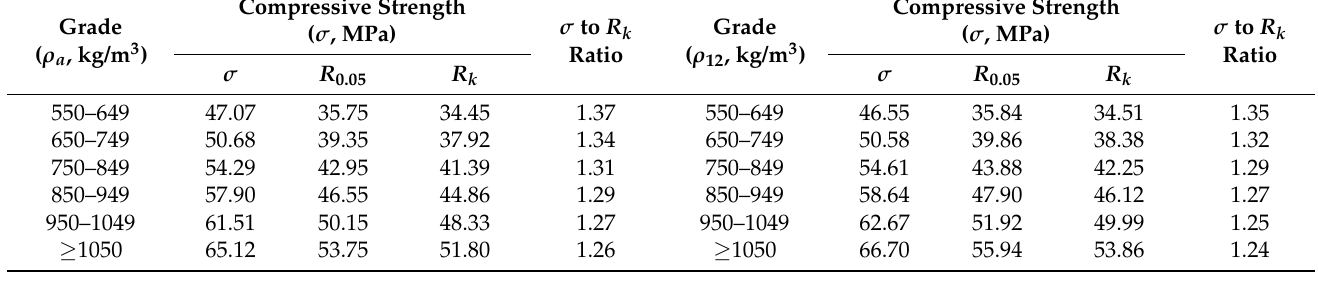
Table 6. Compressive strength grade classification of Dendrocalamus sericeus Munro based on air-dried density and at 12% M C .